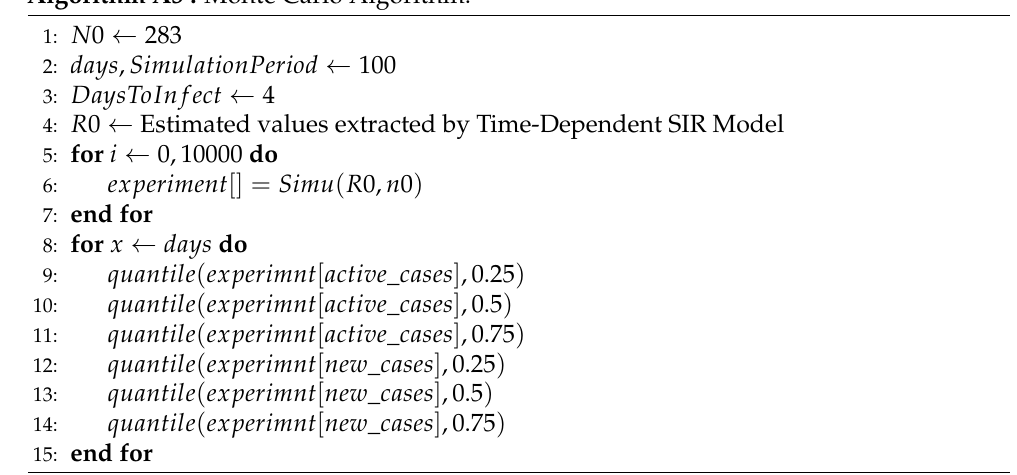
Algorithm A3 : Monte Carlo